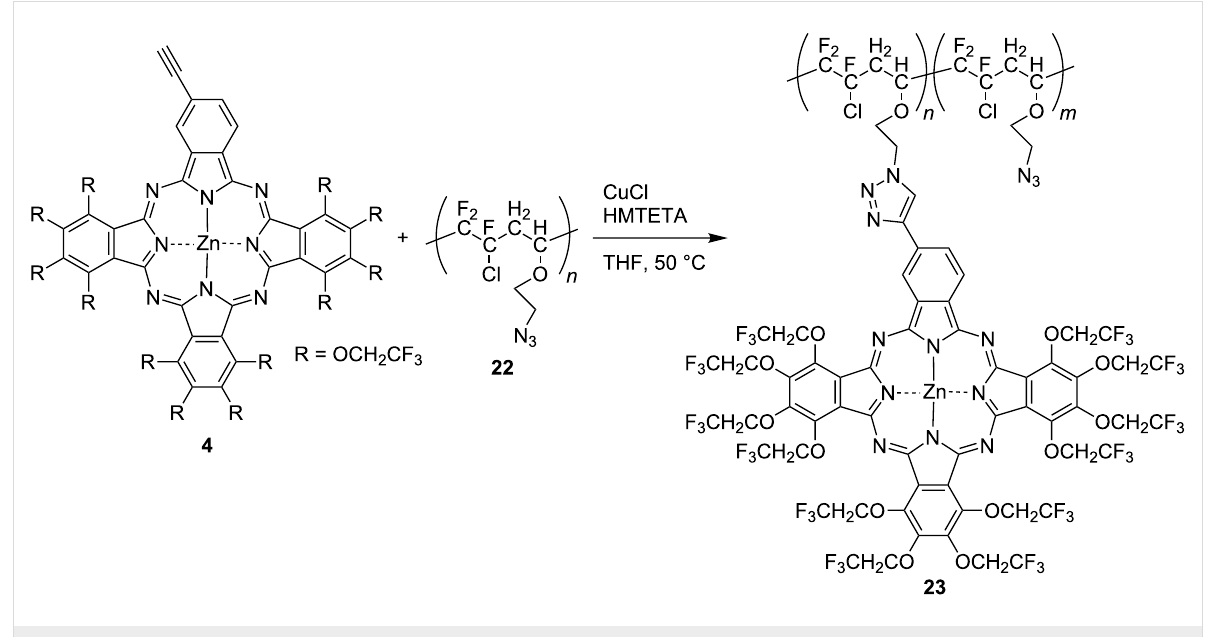
Scheme 8: Synthesis of fluoropolymer-bearing phthalocyanine side